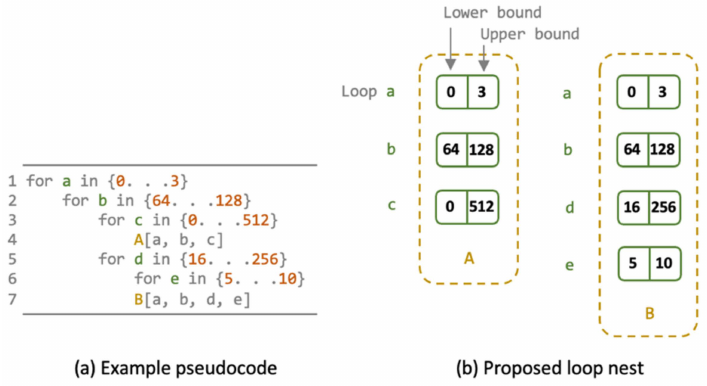
Figure 6. Parallel structure, memory access, and operand expression of the DNN structure. Loop nesting codes are represented by arranging loops from the outermost to the innermost. Thus, features extracted from the loop nest can be stored as the start and end number, as shown in Figure 7.